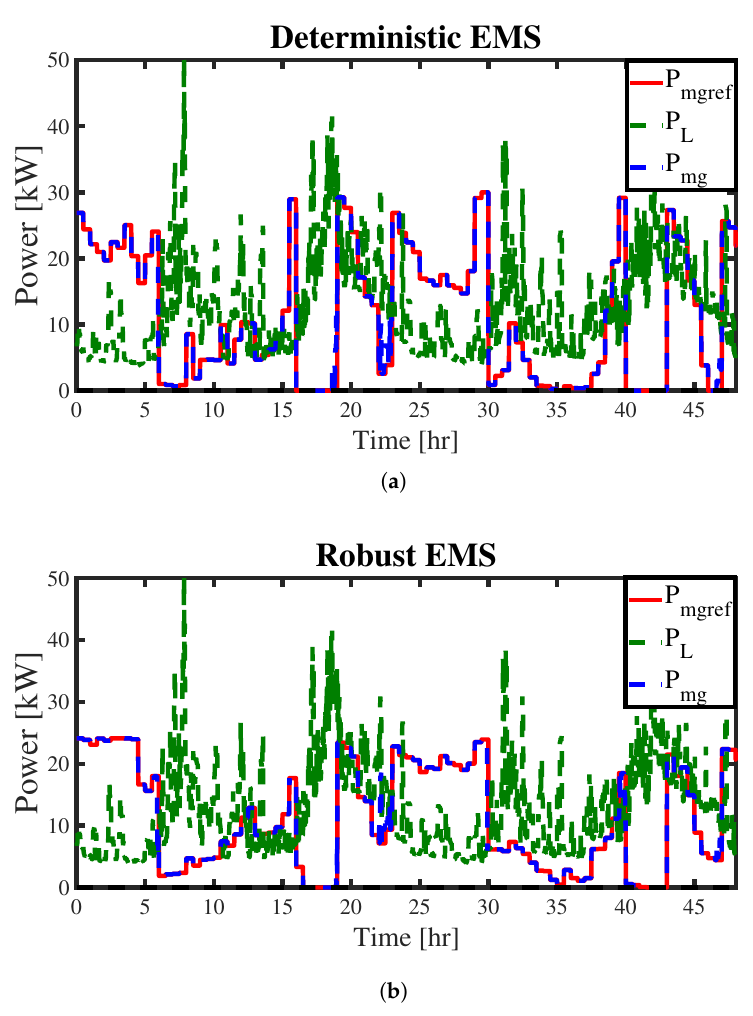
Figure 4. Performance of the proposed hierarchical EMS: ( a ) Deterministic approach; ( b ) Robust